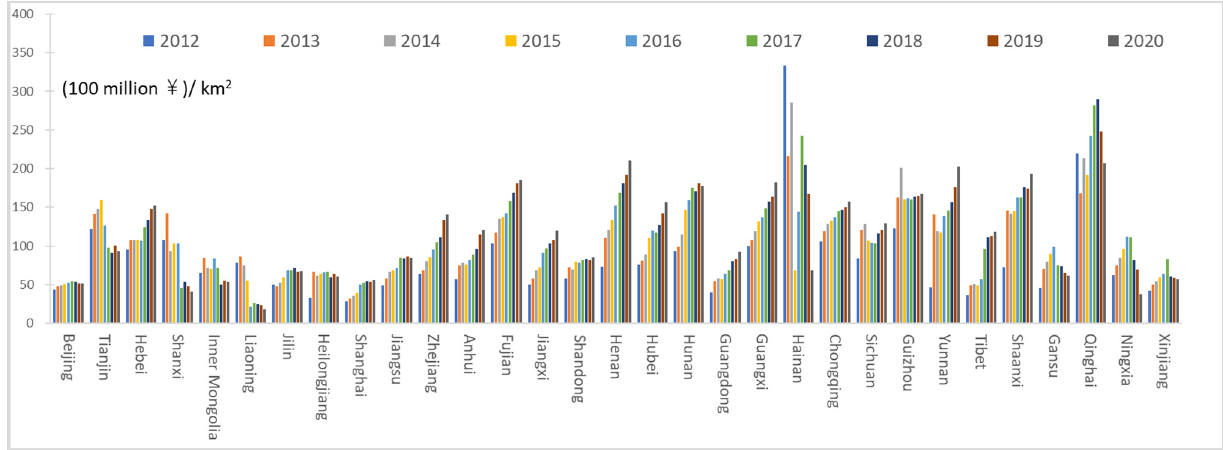
Figure 14. Analysis of change of per unit area investment.